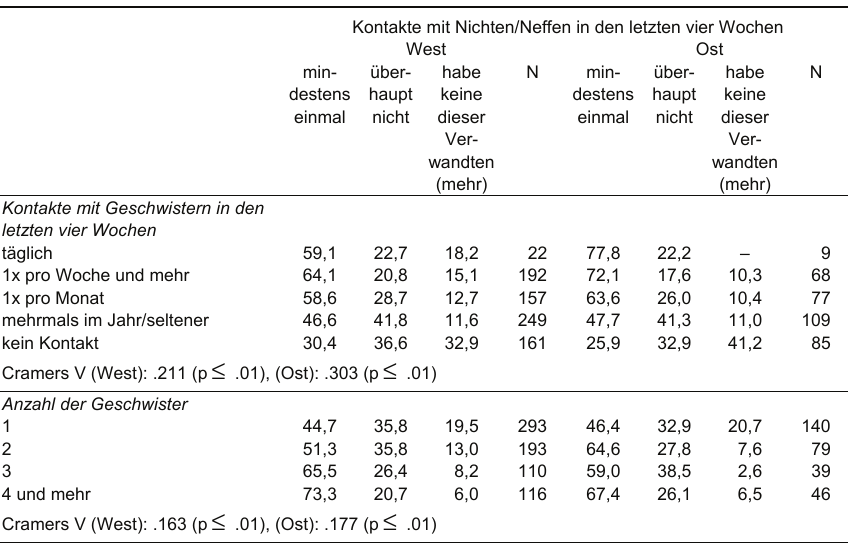
Tab. 3: Bivariate Verteilung der Kontakte mit Nichten/Neffen in den letzten vier Wochen nach familienbiographischen Charakteristiken (Angabe der